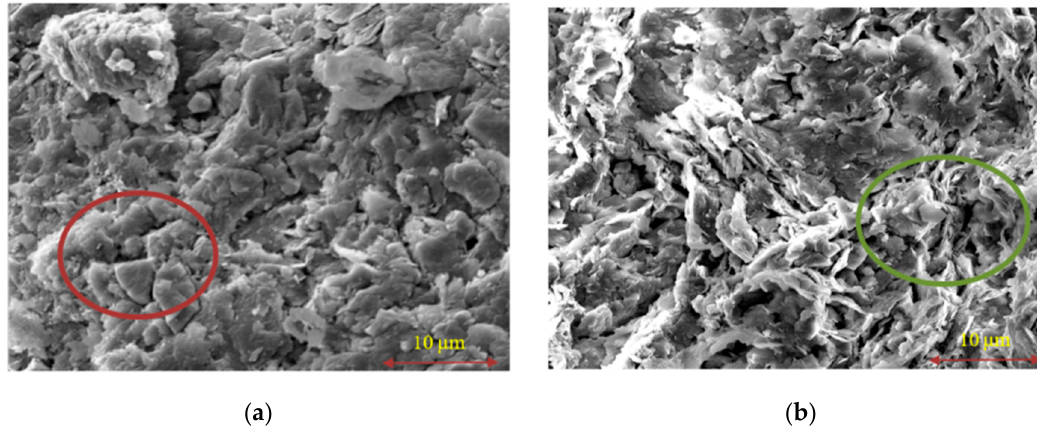
Figure 7. SEM image: ( a ) unfrozen soil; ( b ) frozen soil at − 10 °C.